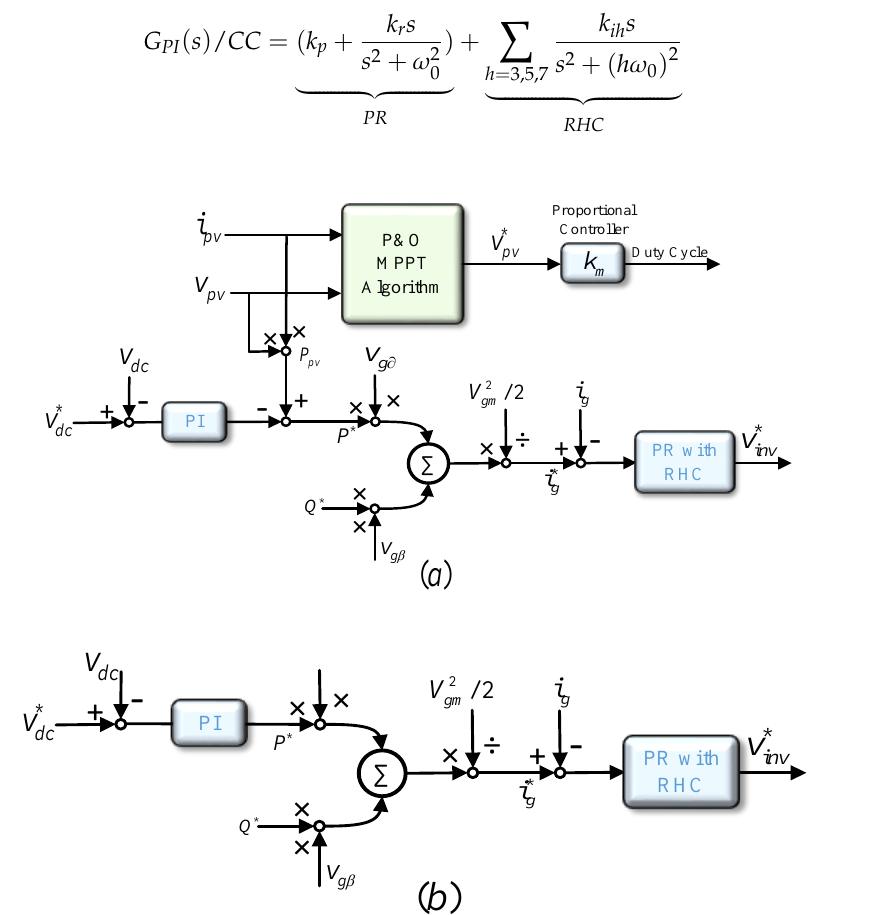
Figure 4. The proportional control loop ( a ) with and ( b ) without feed-forward PV power, respectively.